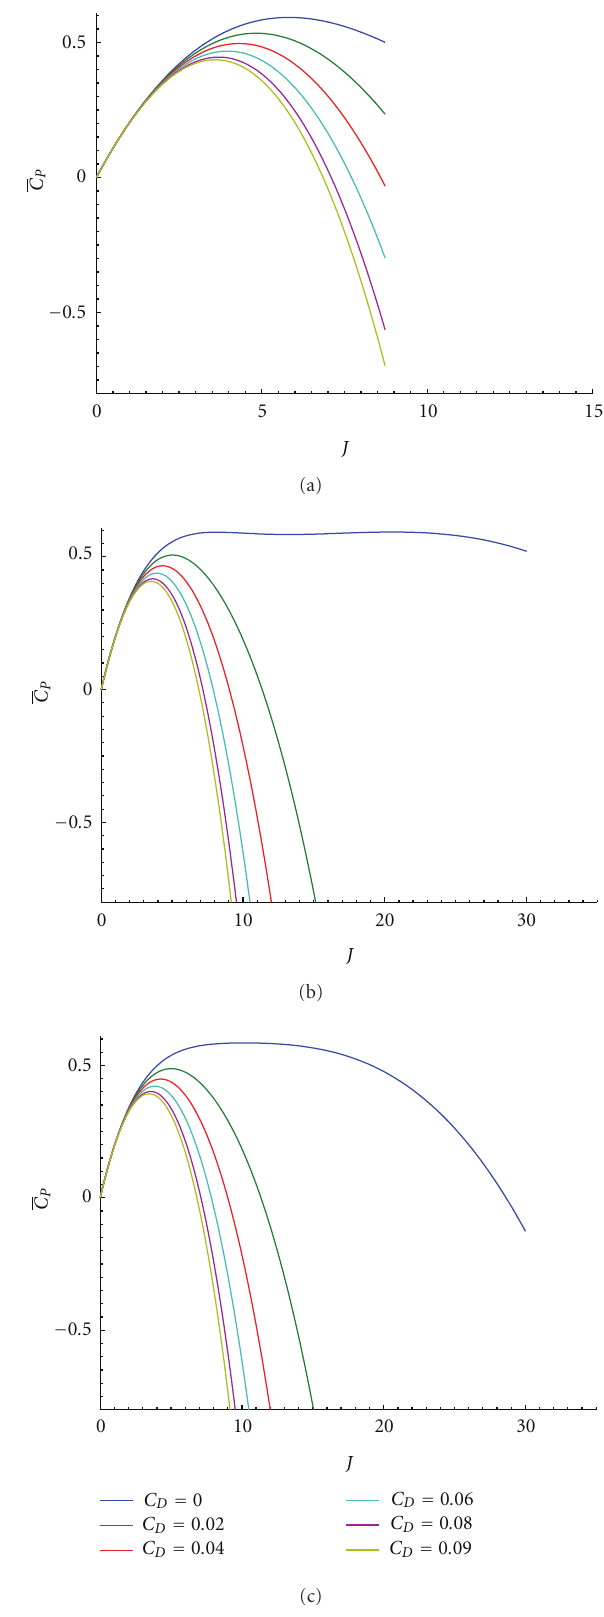
Figure 4: (a) C P versus J for θ = 0 ◦ , (b) C P versus J for θ = 2 ◦ , and (c) C P versus J for θ = 3 ◦